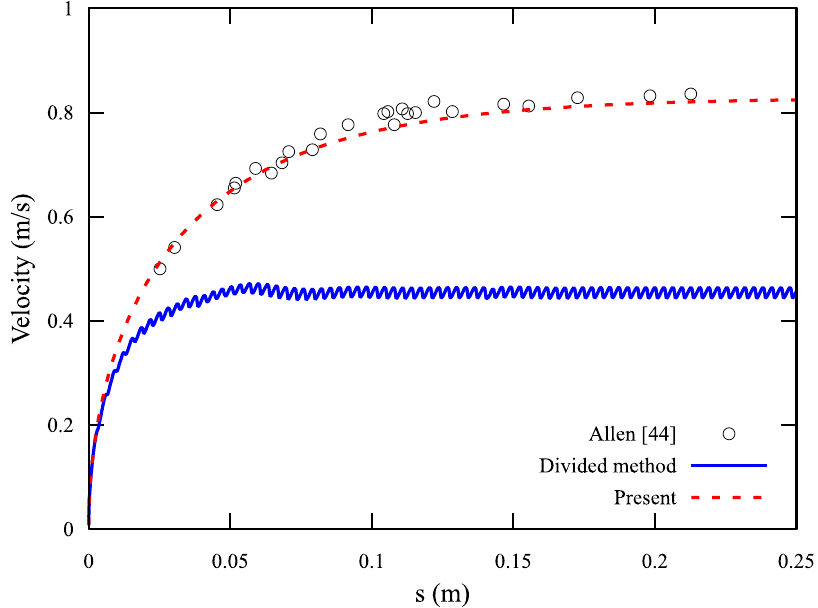
Figure 9. Particle settling velocity and height relationship.